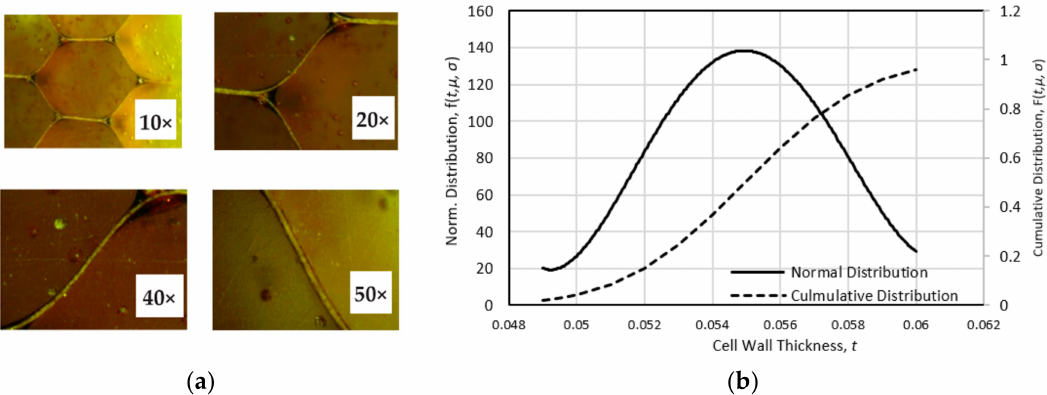
Figure 3. ( a ) Cell-wall thickness of the polymer hexagonal HC core at different magnification, and ( b ) distribution of the wall thickness of the HC